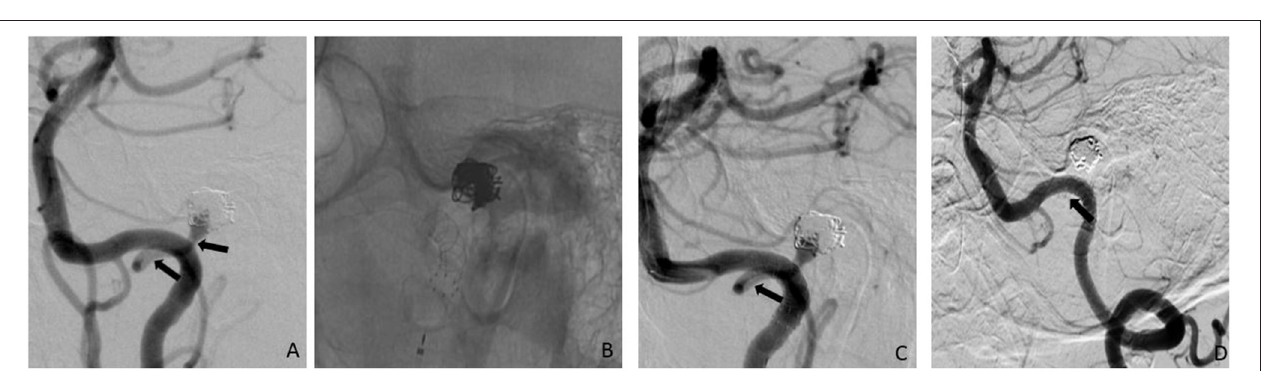
FIGURE 2 | 45 ◦ LAO injection of the left VA showed a recurrence of a formerly ruptured and coiled left PICA aneurysm; arrows indicating the PICA; (B) implantation of a p64 3,5/15mm; (C) final run after the p64 implantation confirmed that the PICA was patent and the aneurysm neck completely covered (arrows = PICA); (D) FU angiography after three months reveal an asymptomatic occlusion of the left PICA (arrow) as well as complete occlusion of the aneurysm. LAO, left anterior oblique; VA, vertebral artery; PICA, posterior inferior cerebellar